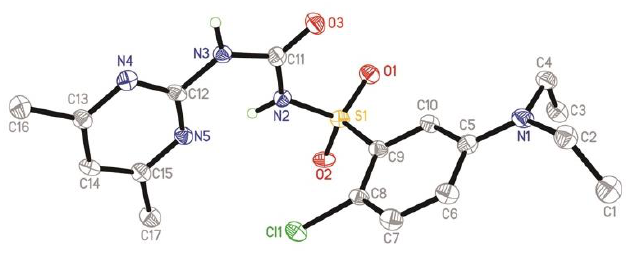
Figure 4. Crystal structure W110